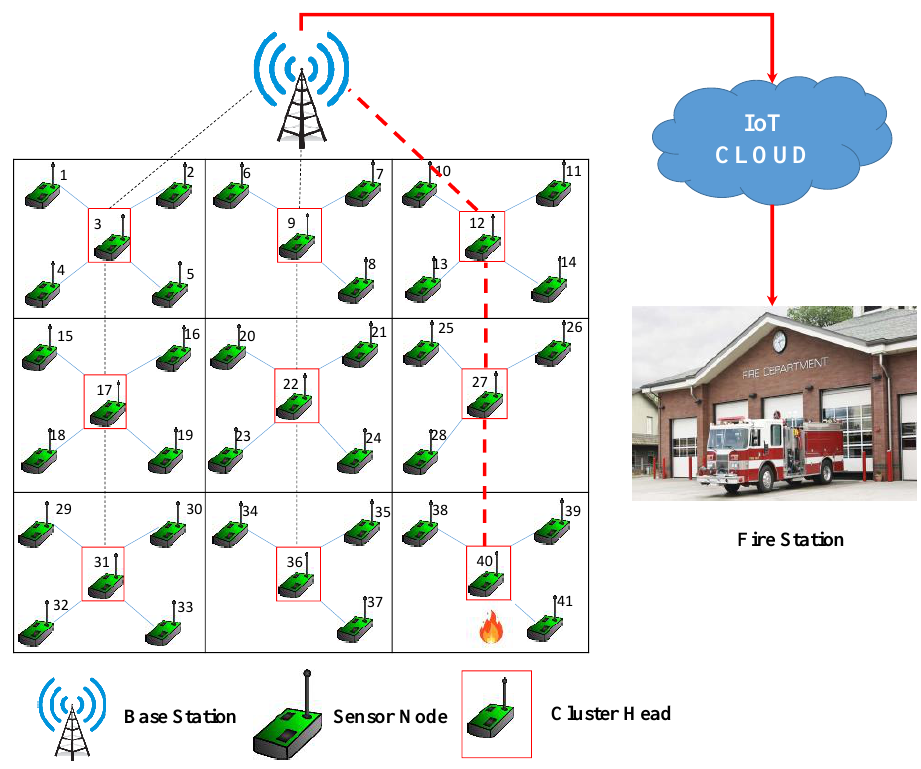
Figure 7. Real-time application of Proposed Model.